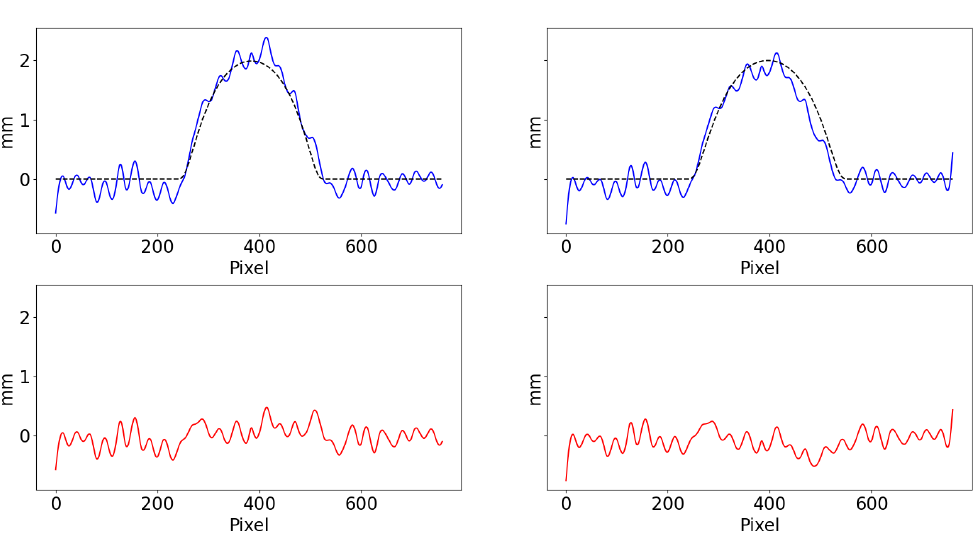
Figure 15. Calculated (solid) and ground truth (dashed) depth of sample A ( top ) and error ( bottom ) along the middle section using direct mapping ( left ) and proposed virtual reference method ( right ). Overall MAE was 0.158mm and 0.126mm, respectively.